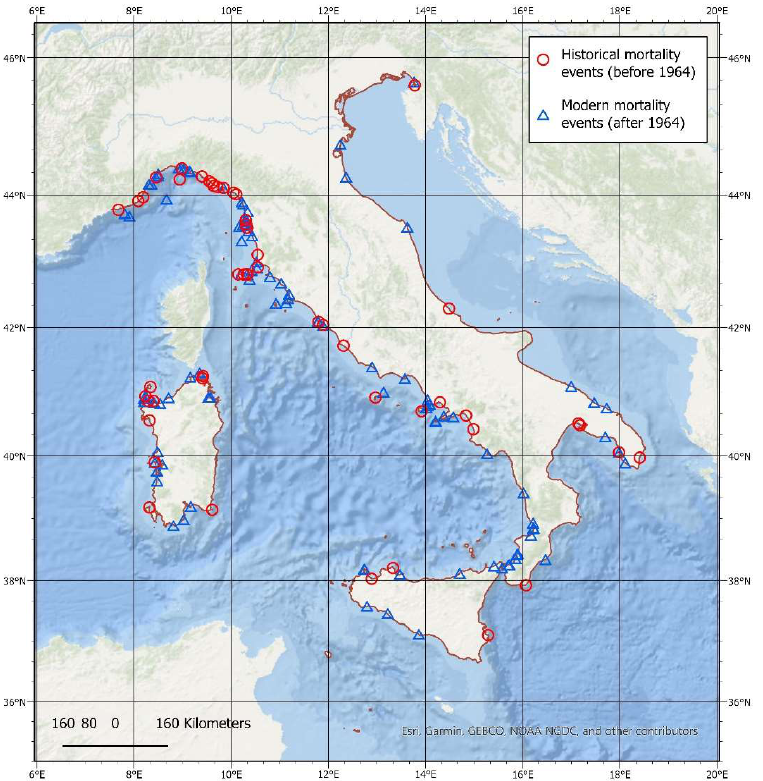
Figure 6. The overall distribution of both historical and modern mortality events along the Italian coast. In order to achieve a quantitative representation of the above condition, we per- formed a cluster analysis by using a non-hierarchical k-means procedure of the spatial location of the events in the Latitude-Longitude space. For a consistent Euclidean space, we limited ourselves to the western basin (Tyrrhenian Sea and Strait of Sicily), which can be considered as unbiased by the spurious underestimation of distances between points separated by land (e.g. , Tuscany and Emilia-Romagna locations). The clustering procedure produced an optimal spatial classification into three classes with an R-square equal to 0.84 (to be compared to an R-square = 0.68 in the case of a Gaussian distribution, with a Pseudo-F value = 256.19, p < 0.0001). The resulting clusters (Figure 7) are the Ligu- ria-Tuscany (Cluster 1), Sardinia (Cluster 2), and a southern one (Cluster 3).